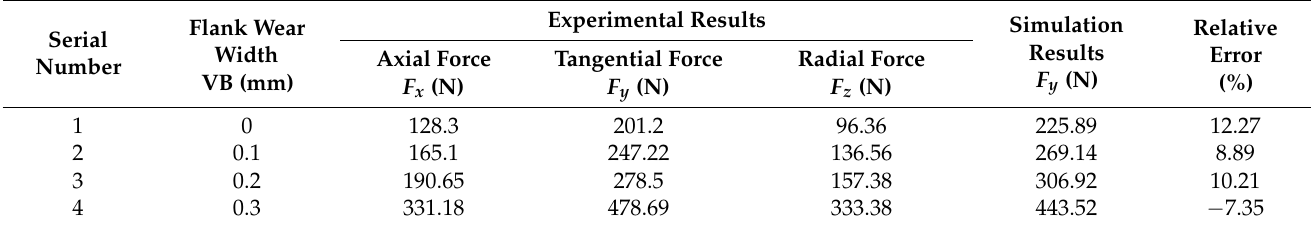
Table 6. Comparison of cutting force data.